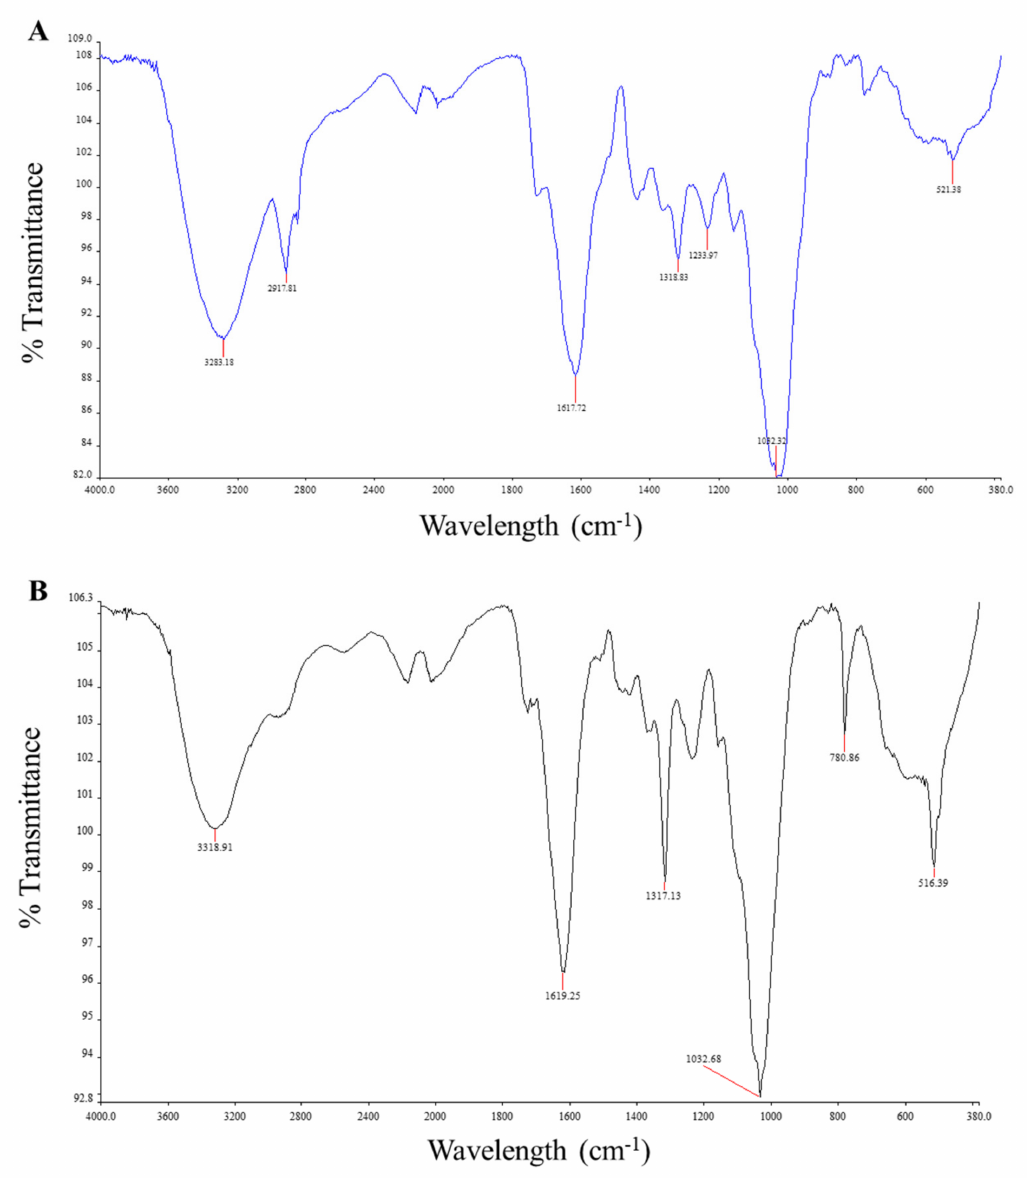
Figure 1. FTIR spectra of powdered ( A ) leaf and ( B ) stem samples of Combretum molle